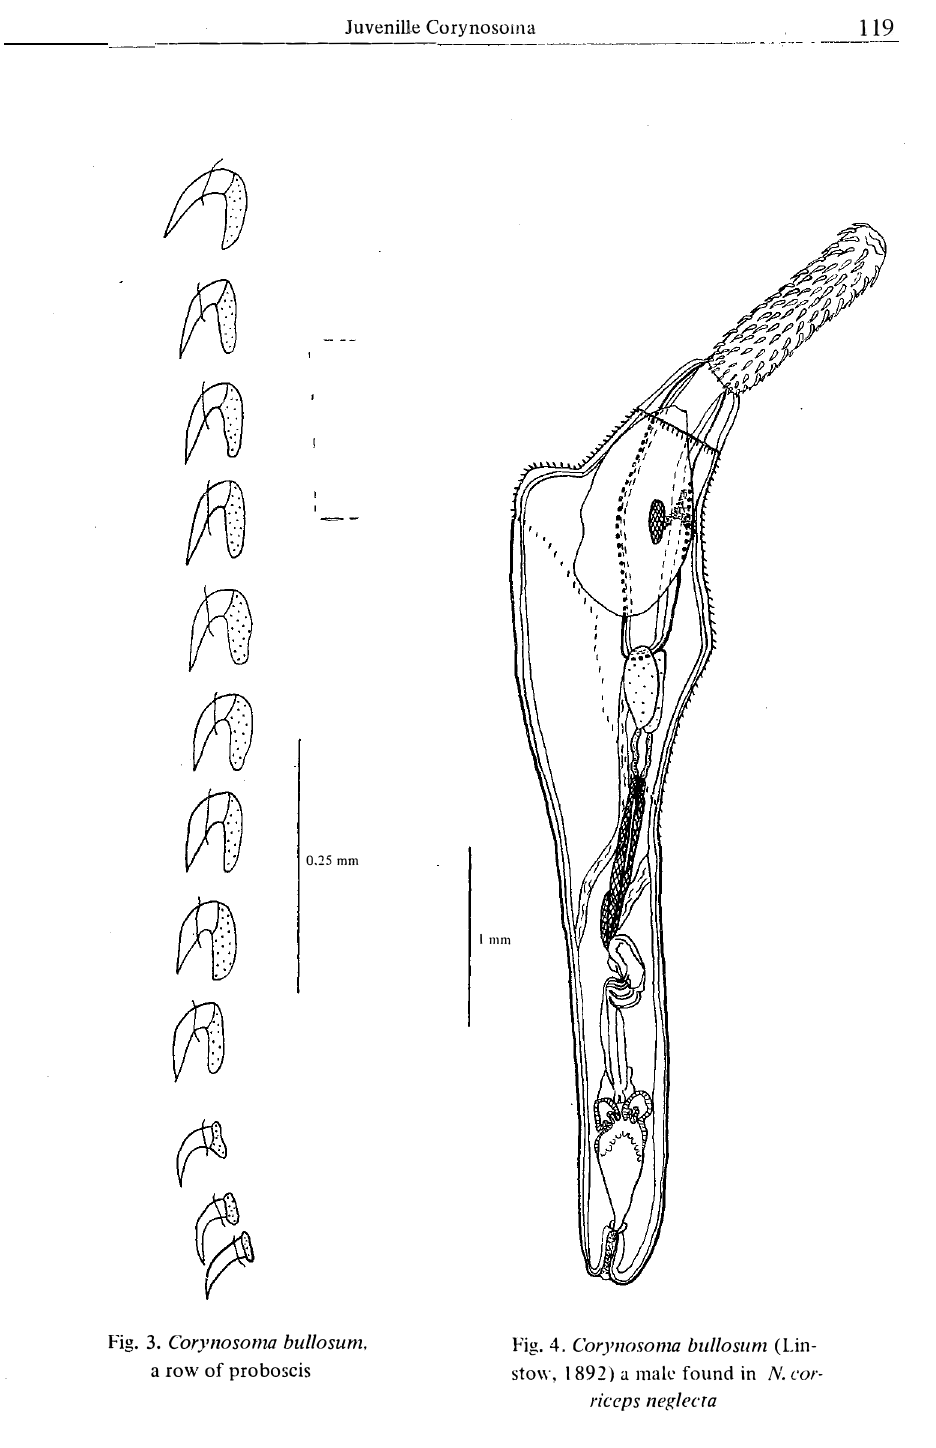
Fig. 4. Corynosoma bullosum (Lin­ stow, 189.2) a mak found in N. cor­ riccps